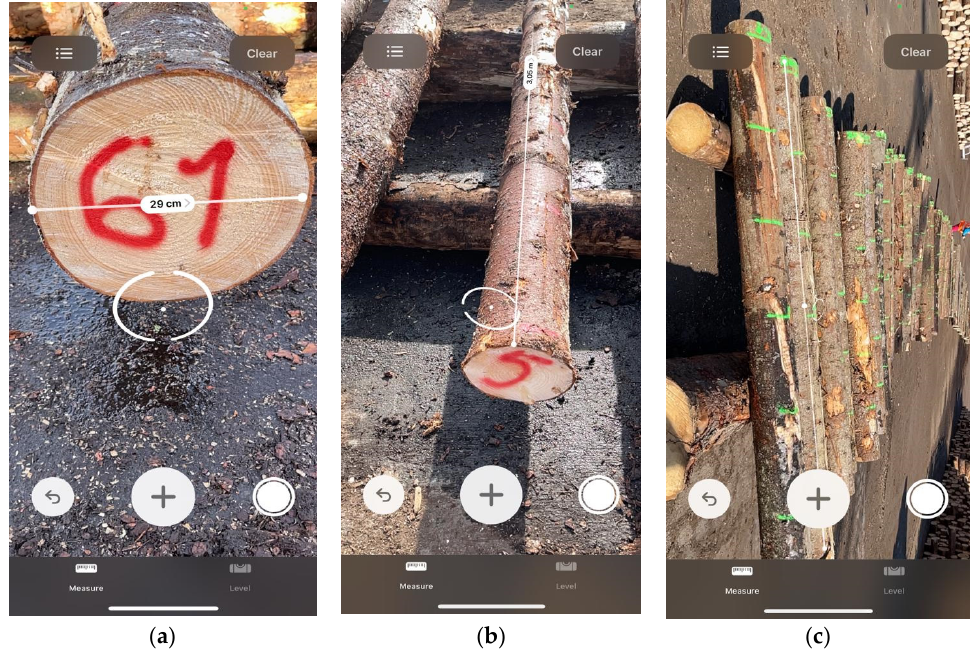
Figure 2. Examples of diameter and length measurements by the Measure app of iPhone in the first experiment (E1): ( a ) an example of using the Measure app and AR for diameter measurement; ( b ) an example of using the Measure app and AR for length measurement; ( c ) perspective in AR over a group of logs and a measurement on log